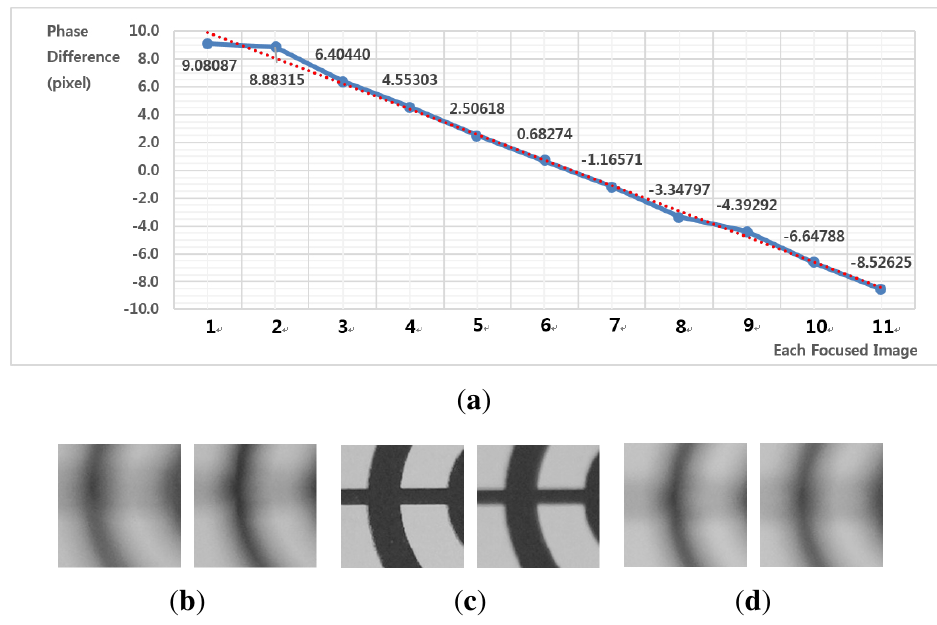
Figure 14. Results of motion estimation for different phases: ( a ) estimated motion vectors versus the phase difference; ( b ) pair of left- and right-phase images at the front-focus position (Image 1) with a phase difference of 9.08087; ( c ) at the in-focus position (Image 6) with a phase difference of − 0.68274; and ( d ) at the far-focus position (Image 11) with a phase difference of −